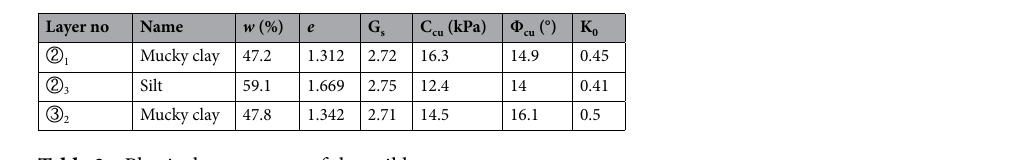
Table 3. Physical parameters of the soil